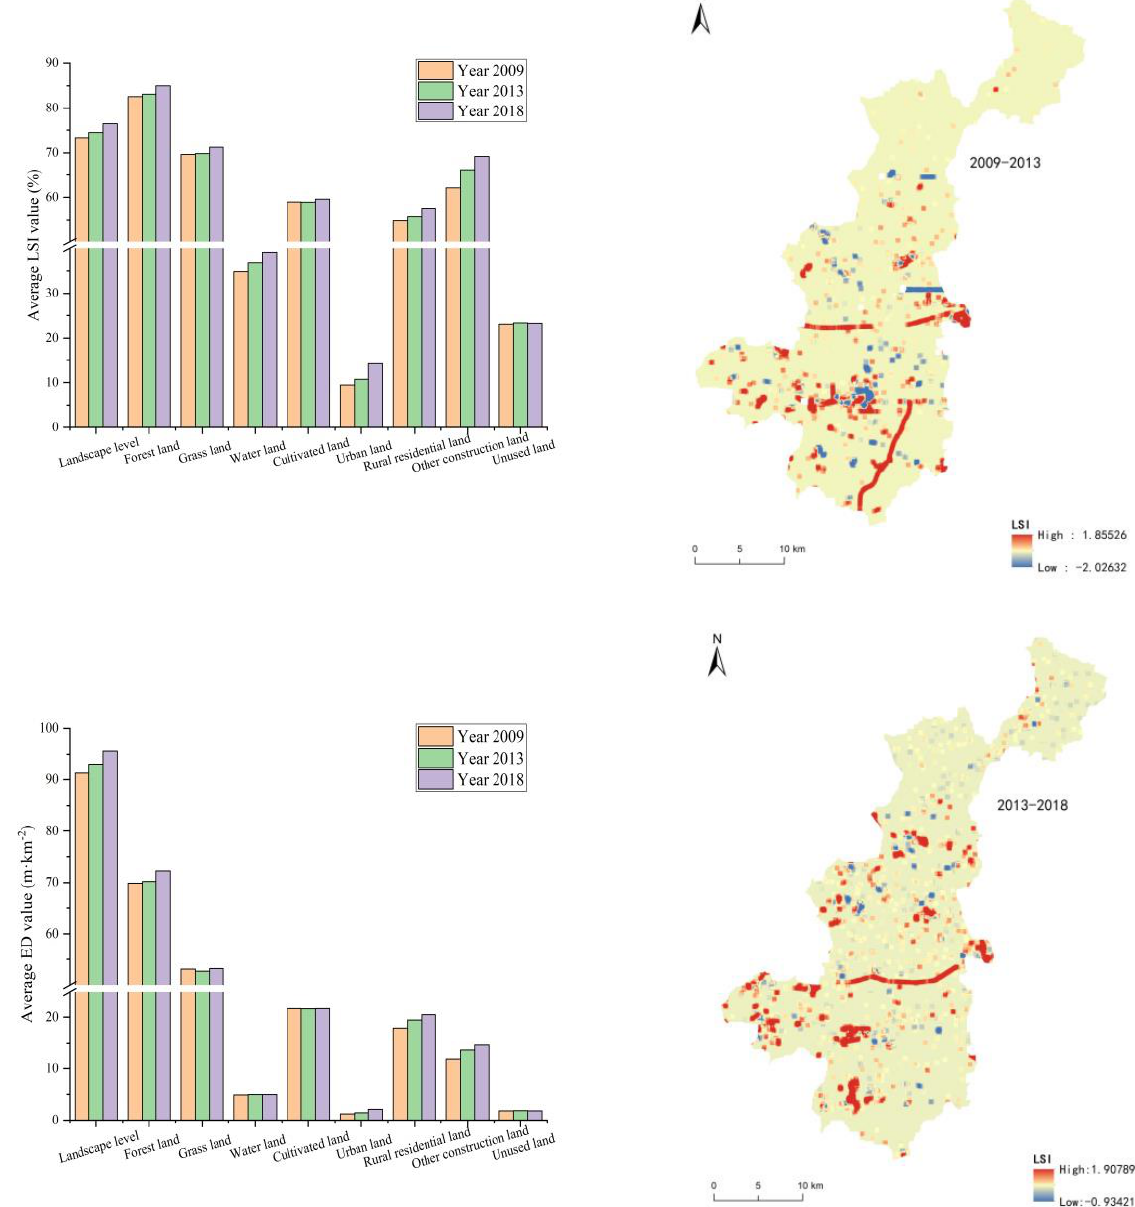
Figure 6. Change in landscape patch shape in Yujiang District from 2009 to 2018.